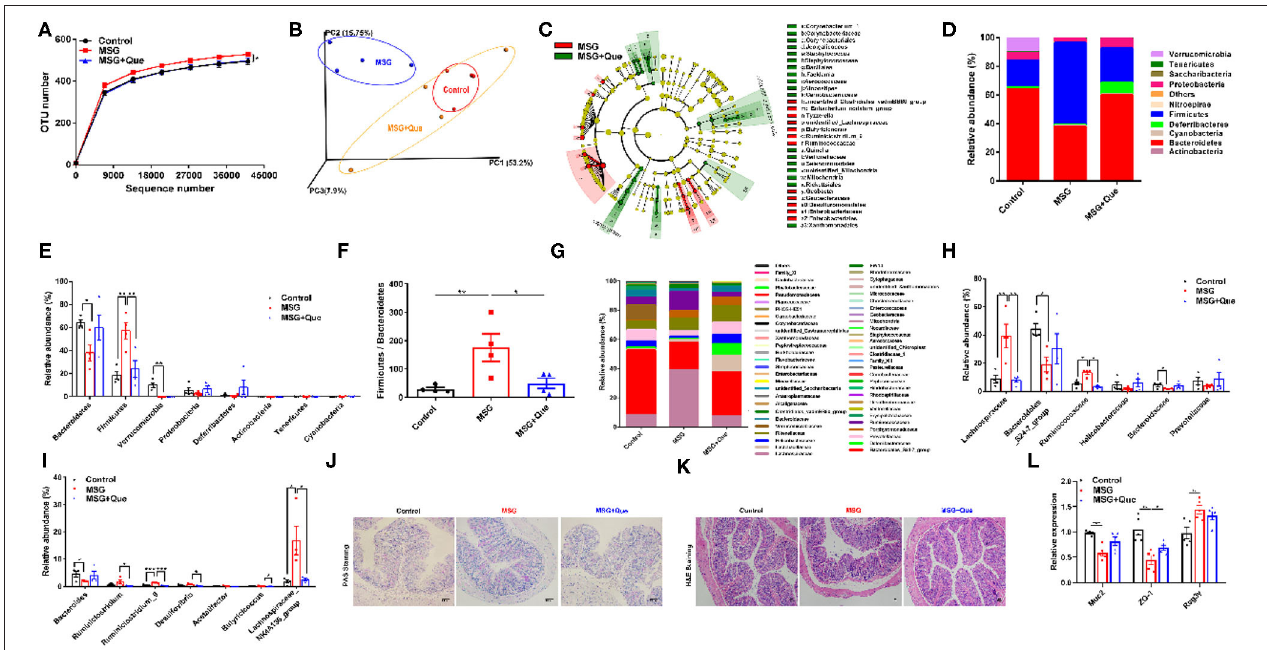
FIGURE 5 | MSG-driven microbiota dysbiosis and damaged gut barrier is attenuated after the quercetin treatment. (A) OTU number and (B) Weighted Unifrac analysis of the control, MSG and MSG + Que group. (C) LEfSe analysis of microbiota in the MSG and MSG + Que group. (D) Microbiota composition and (E) relative abundance of gut flora at the phylum level. (F) The ratio of Firmicutes to Bacteroidetes . (G) Microbiota composition and (H) relative abundance of gut microbiota at the family level. (I) Relative abundance of flora at the genus level. (J) PAS staining and (K) H&E staining of colon tissue. Scale bar: 20 µ m. (L) The gene expression of Muc2 , ZO-1, and Reg3 γ in colon tissues. Data are presented as mean ± SEM, n = 4–6. Data were analyzed by one-way ANOVA followed by post-hoc LSD tests. * p < 0.05, ** p < 0.01, *** p <